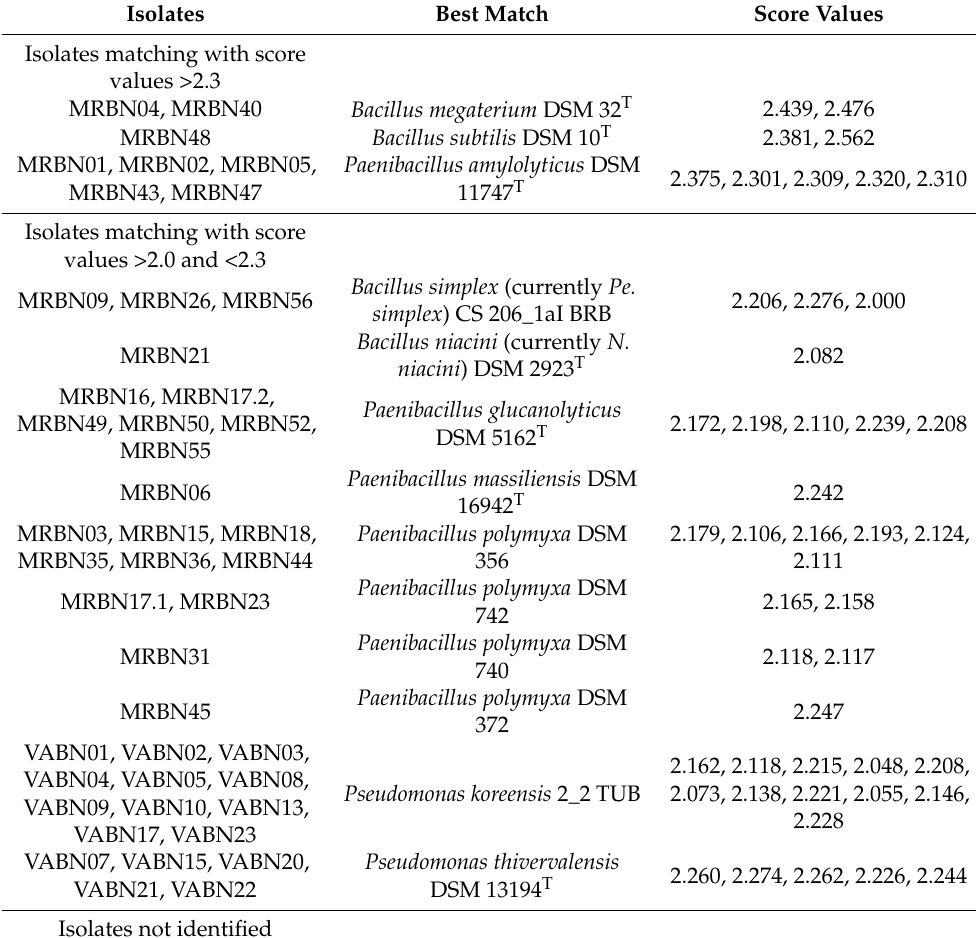
Table 1. Results of the MALDI-TOF MS Analysis. Isolates Best Match Score Values Isolates matching with score values >2.3 MRBN04, MRBN40